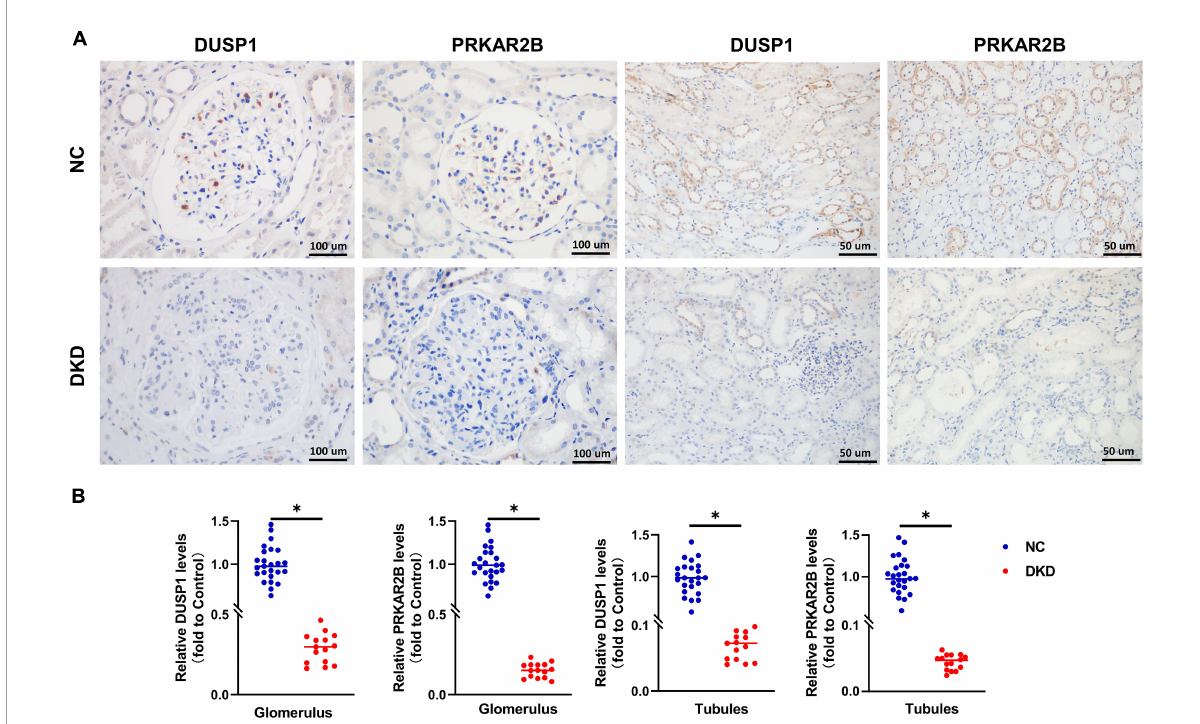
FIGURE6 Clinical validation of the identified gene biomarkers expression in DKD kidney tissues and normal kidney tissues. (A) Representative images and (B) statistical analyses of immunohistochemical staining for DUSP1 and PRKAR2B. P <